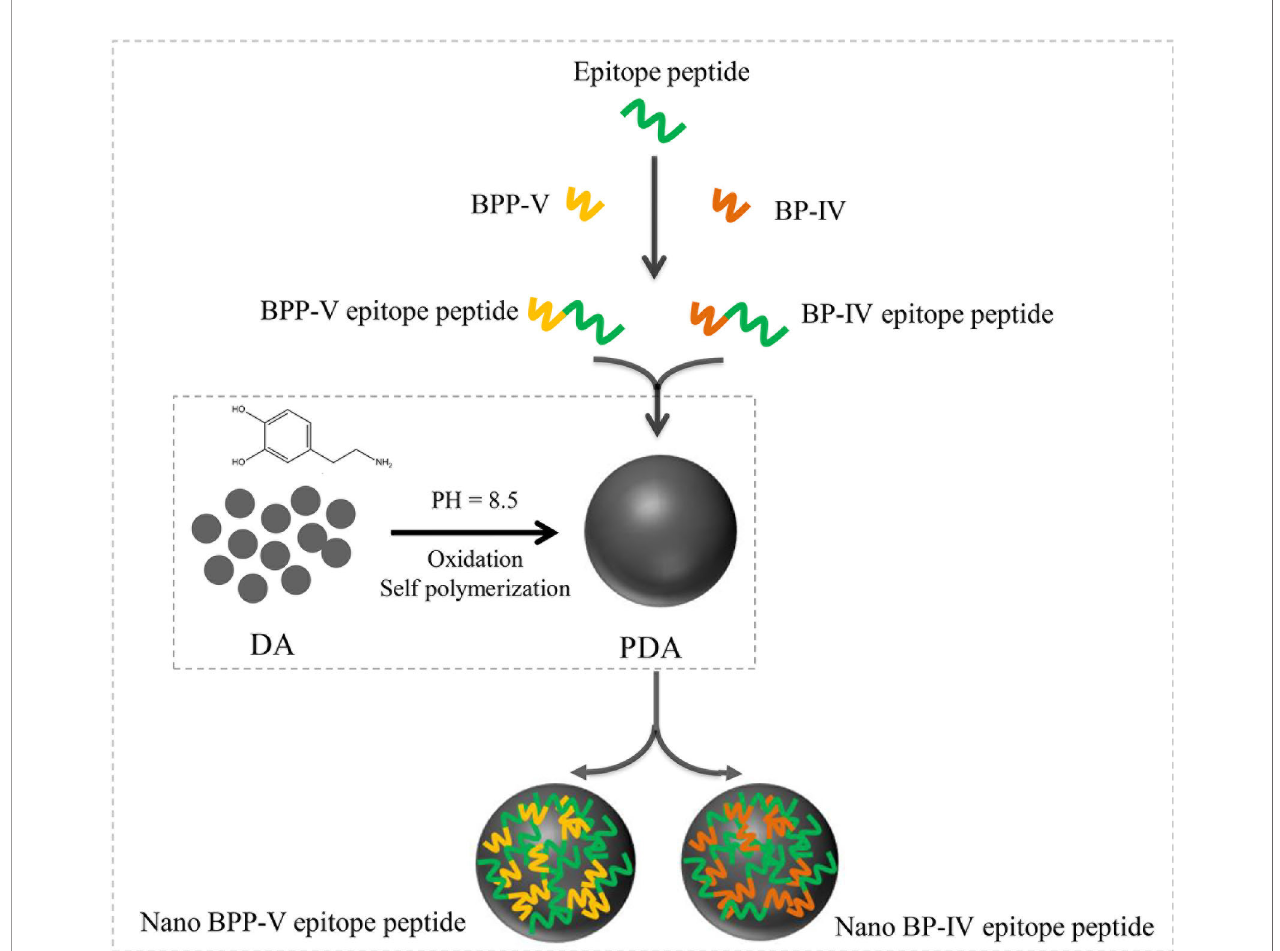
FIGURE 1 | Process diagram of nano BPP-V and BP-IV epitope peptide construction. The epitope peptide was selected by immunoinformatics analysis. As immune adjuvants, BPP-V and BP-IV were conjugated with the epitope peptide to form the BPP-V and BP-IV epitope peptides. Then, the BPP-V and BP-IV epitope peptides were coupled with polydopamine (PDAs microspheres) to form the nano BPP-V and BP-IV epitope peptides vaccines. PDA, a new versatile biomaterial, was synthesized by the oxidation and self-polymerization of dopamine hydrochloride under alkaline